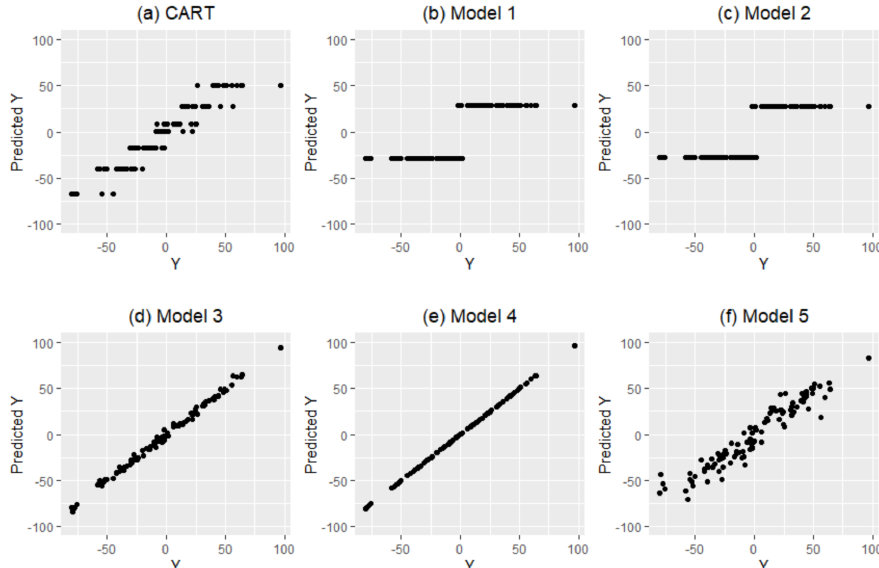
Figure 4. The scatter plot of Y and the predicted values using CART and the projection pursuit regression model with methods Models